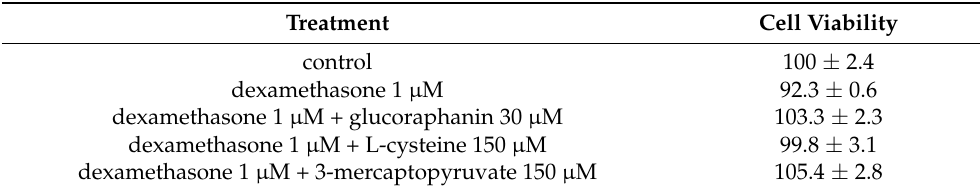
Table 1. Cell viability in C2C12 myotubes (10 × 10 3 /well) treated for 48 h with DEX 1 μM in presence or absence of 30 μM glucoraphanin, 150 μM L-cysteine, and 150 μM mercaptopyruvate. Cell viability was evaluated by MTT assay. We arbitrarily set the control condition as 100%. Values are expressed as the mean ± S.E.M. of 3 experiments.